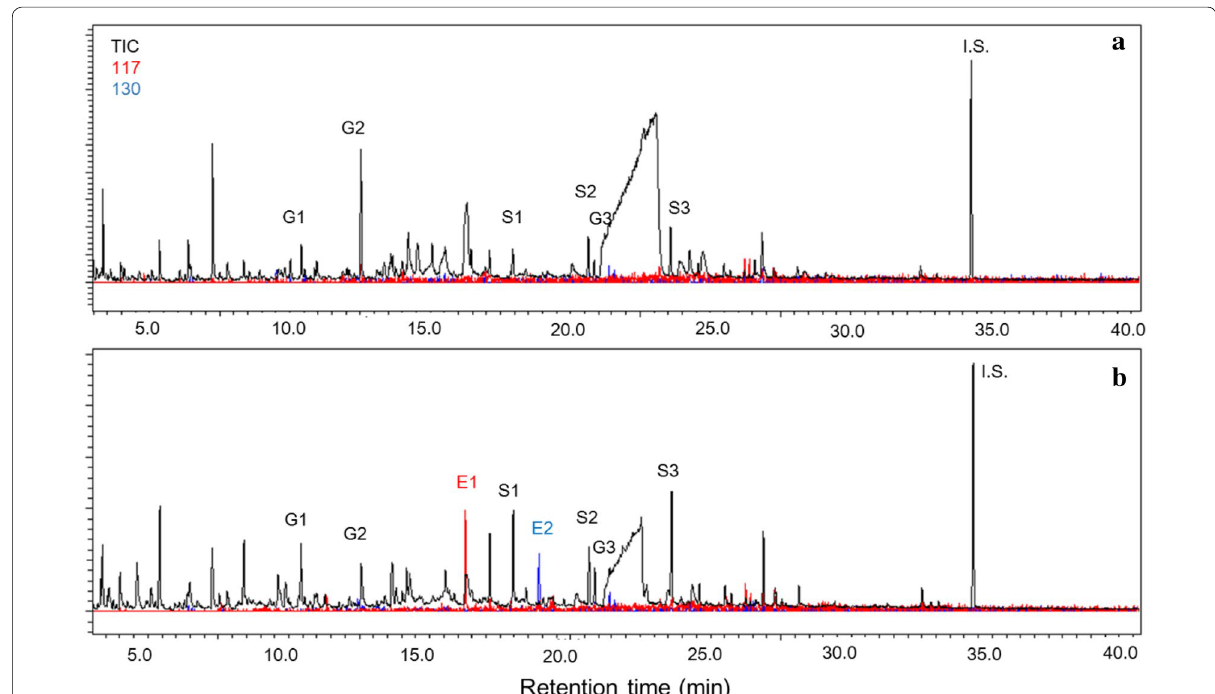
Fig. 3 Pyrogram of lignin and the adsorbed enzyme in acacia SP according to Py‑GC/MS: a untreated and b enzyme‑treated. Notes: G1: guaiacol, G2: 4‑methylguaiacol, G3: trans ‑isoeugenol, S1: syringol, S2: 4‑methylsyringol, S3: 4‑vinylsyringol, E1 and E2: molecular fragments (with m/z 117 and 130) produced by the enzyme, I.S., internal standard